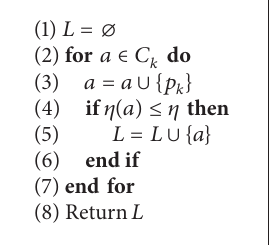
Algorithm 2: Function candidates ( 𝐶 𝑘